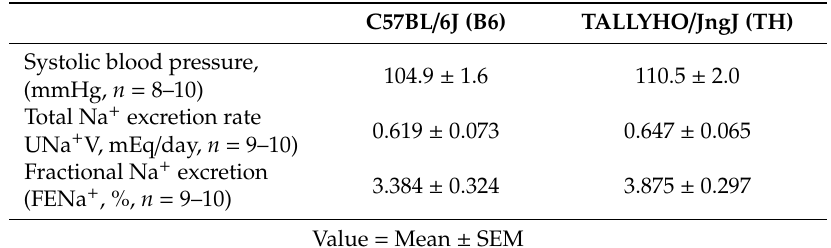
Table 1. Systolic blood pressure, total and fractional excretion of Na + in C57BL / 6J and TALLYHO / JngJ mice on normal